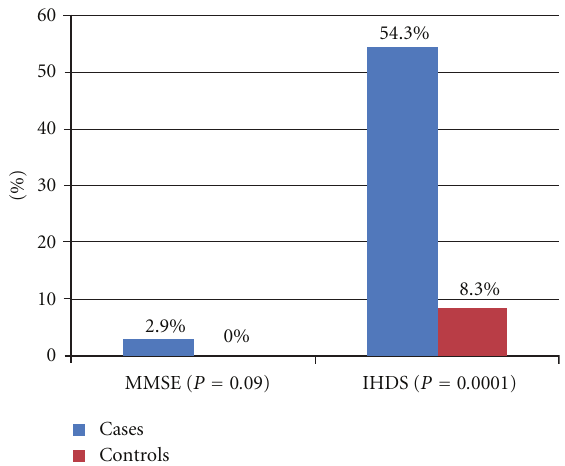
Figure 3: Frequency of cognitive impairment based on the MMSE and IHDS scores of cases (HIV-positive) and controls (HIV-